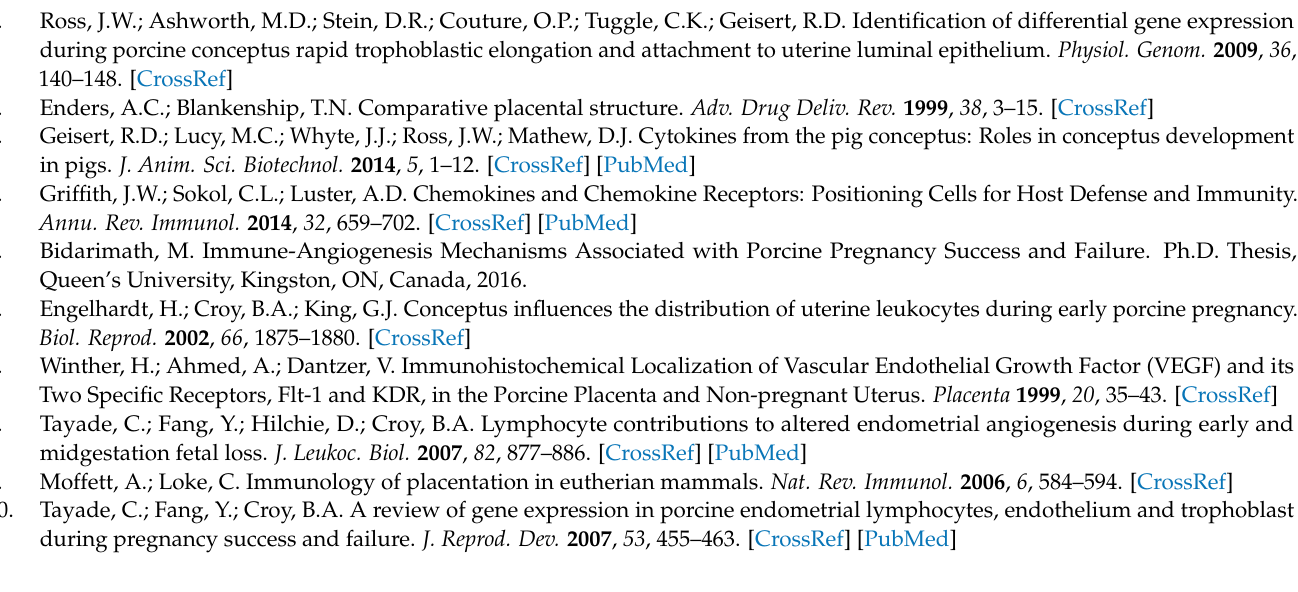
tary Table S1: Primer sequence for the lncRNAs and genes for Real-time RT-PCR, Supplementary Table S2: Summary of high-throughput sequencing in HE and AE, Supplementary Table S3: The values of Pearson’s correlation coefficient, Supplementary Table S4: FPKM of DELs and DEGs in HE and AE, Supplementary Table S5: GO enrichment and KEGG pathway analysis of nearest target genes of DELs or DEGs, Supplementary Table S6: Validation of RNA-seq results by using qRT-PCR, Sup- plementary Table S7: Immunobiological process gene sets, Supplementary Table S8: Immune genes from the Immport database/endometrium spontaneous abortion genes from the GeneCard database, Supplementary Table S9: Pearson correlation coefficient of lncRNAs and genes, Supplementary Table S10: Conserved sequences of the lncRNA in different